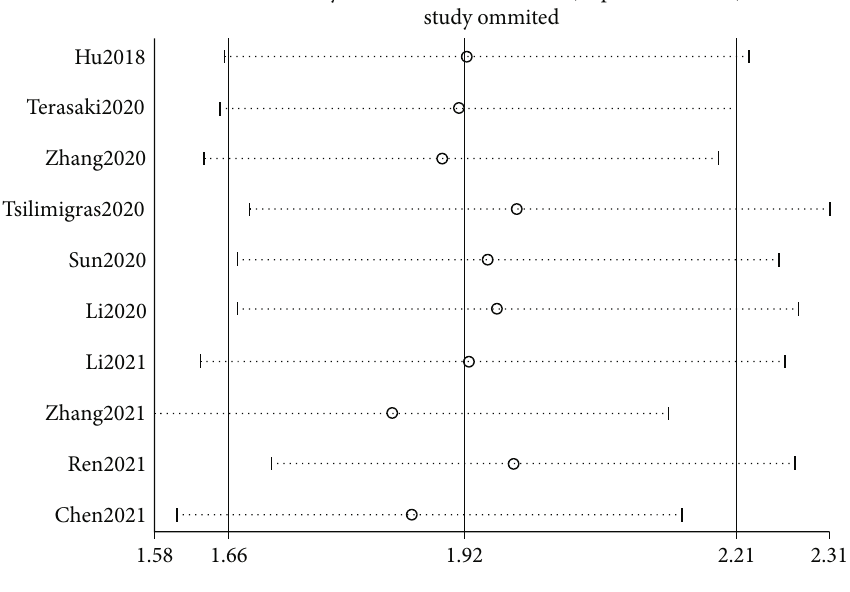
Figure 4: Sensitivity analysis for the OS.